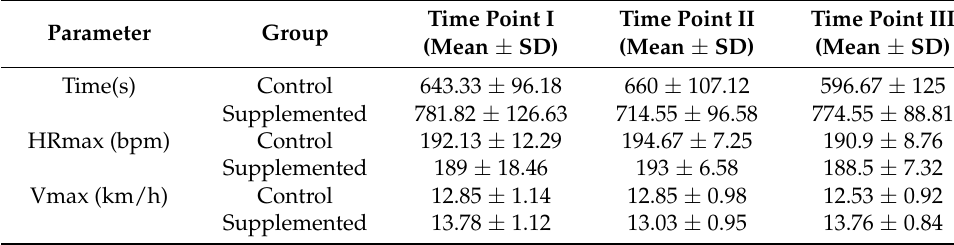
Table 1. Basic characteristics of the studied groups (mean ± standard deviation